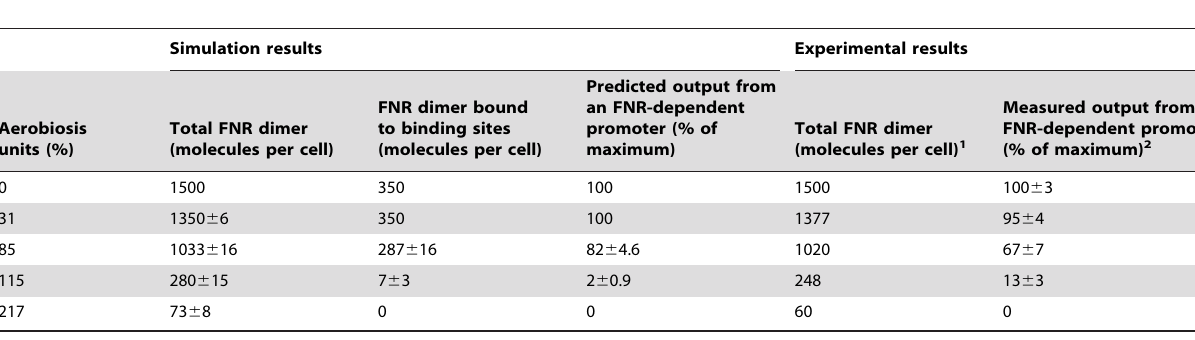
Table 5. Comparison between experimental and simulation results for wild-type FNR.